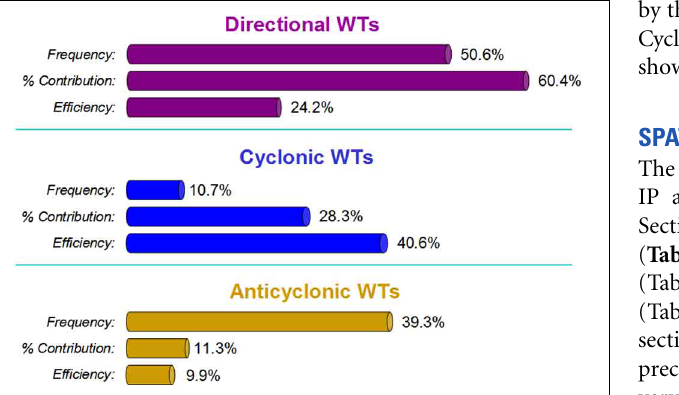
FIGURE 4 | Monthly mean of WT Frequency, Percentage Contribution, and Precipitation Efficiency for the three main WT classes: Directional (N, NE, E, SE, S, SW, W, NW), Cyclonic (C, CN, CNE, CE, CSE, CS, CSW, CW, CNW), and Anticyclonic (A, AN, ANE, AE, ASE, AS, ASW, AW and